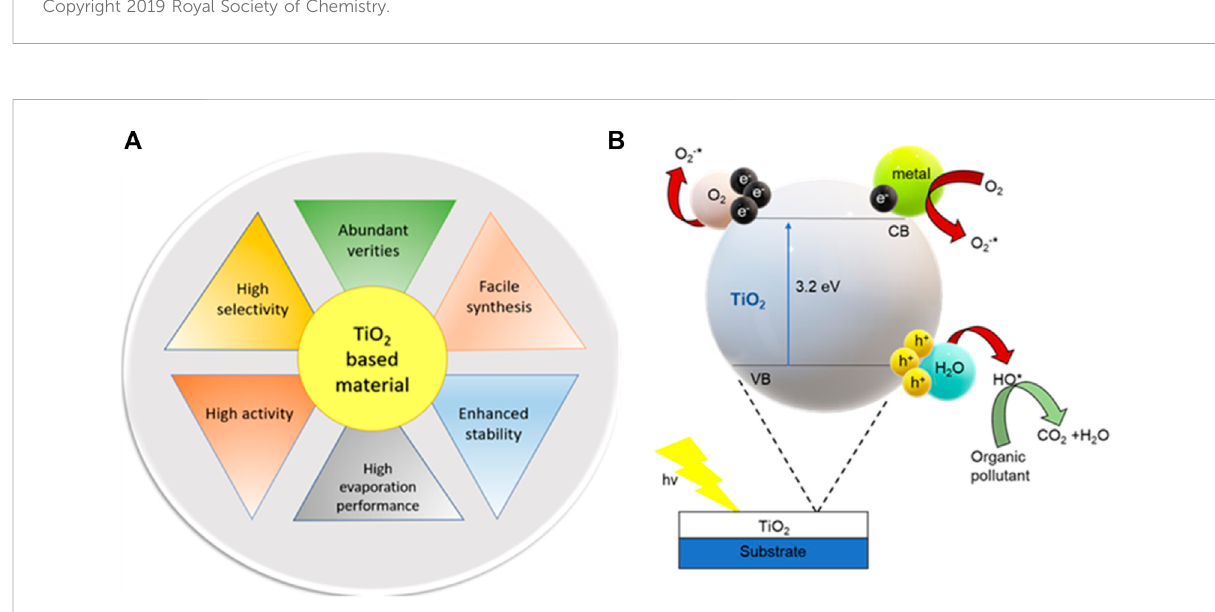
FIGURE 2 (A) Illustration of electron-hole generation and relaxation in a typical semiconductor (J. Wang et al., 2017b); Reproduced with permission. Copyright 2017 John Wiley and Sons. (B) Schematic of non-radiative relaxation in a semiconductor (Gao et al., 2019); Reproduced with permission. Copyright 2019 Royal Society of